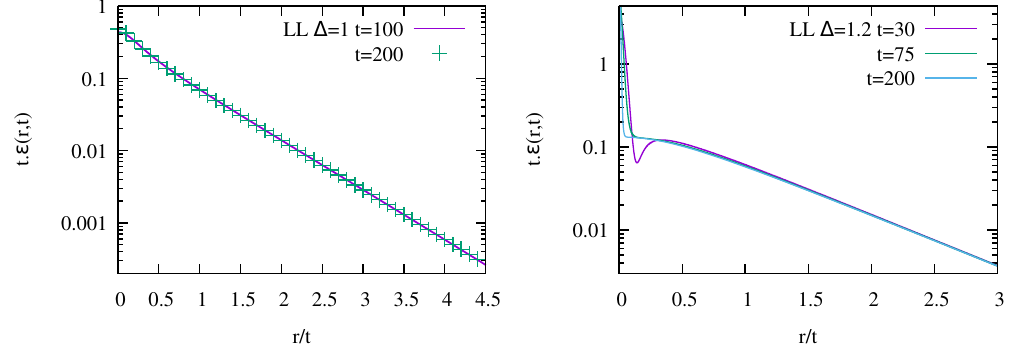
Figure 15: Left panel: LL energy density multiplied by t in the isotropic case ( ∆ = 1). Away from the center the energy density appears to decay as exponen- tially, ε ( r , t ) t ∼ exp ( − cr / t ) with c (cid:39) 1.6. See Sec. 7.7 for an explanation of this behavior (variational approach). Right panel: LL energy density multiplied by t in an easy-axis case ( ∆ = 1.2). At long times we again have ε ( r , t ) t ∼ exp ( − c (cid:48) r / t ) for r / t > 0, but a different behavior for | r | (cid:28) t (see Sec.